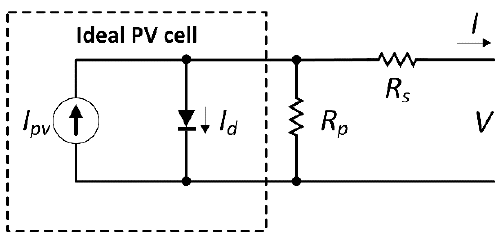
Figure 2. Equivalent circuit of the Rp-model.